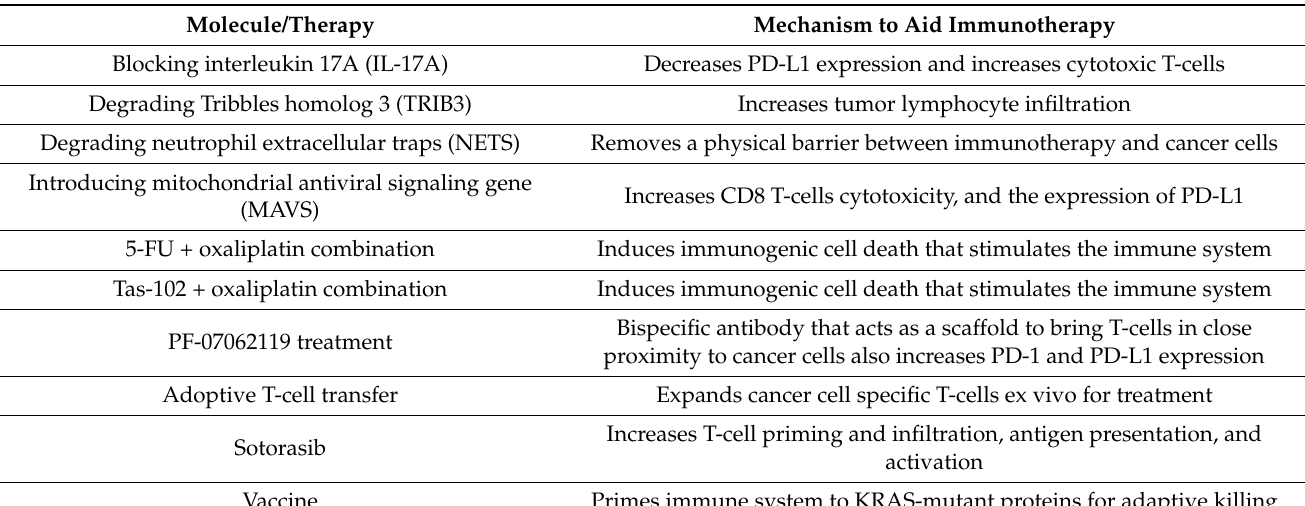
Table 3. Current molecules and methods evaluated to increase the response of immunotherapy in colorectal